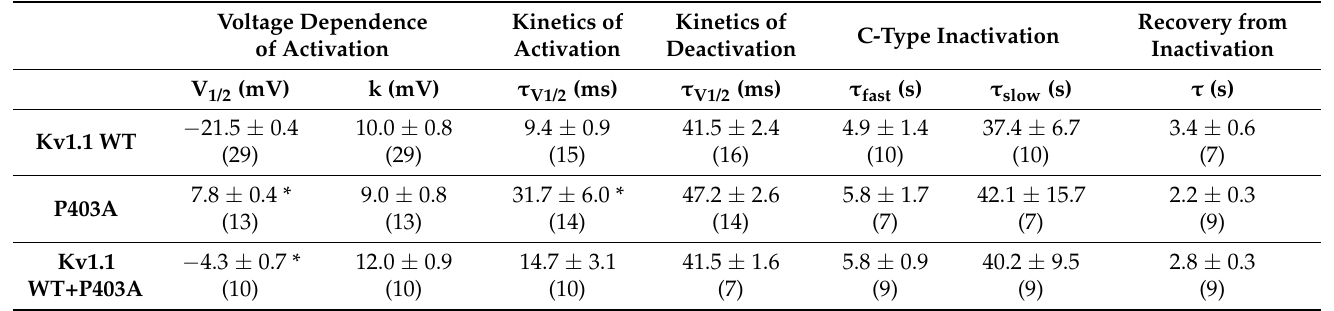
Table 1. Biophysical parameters of Kv1.1 WT, P403A and Kv1.1 WT+P403A channels expressed in HEK 293